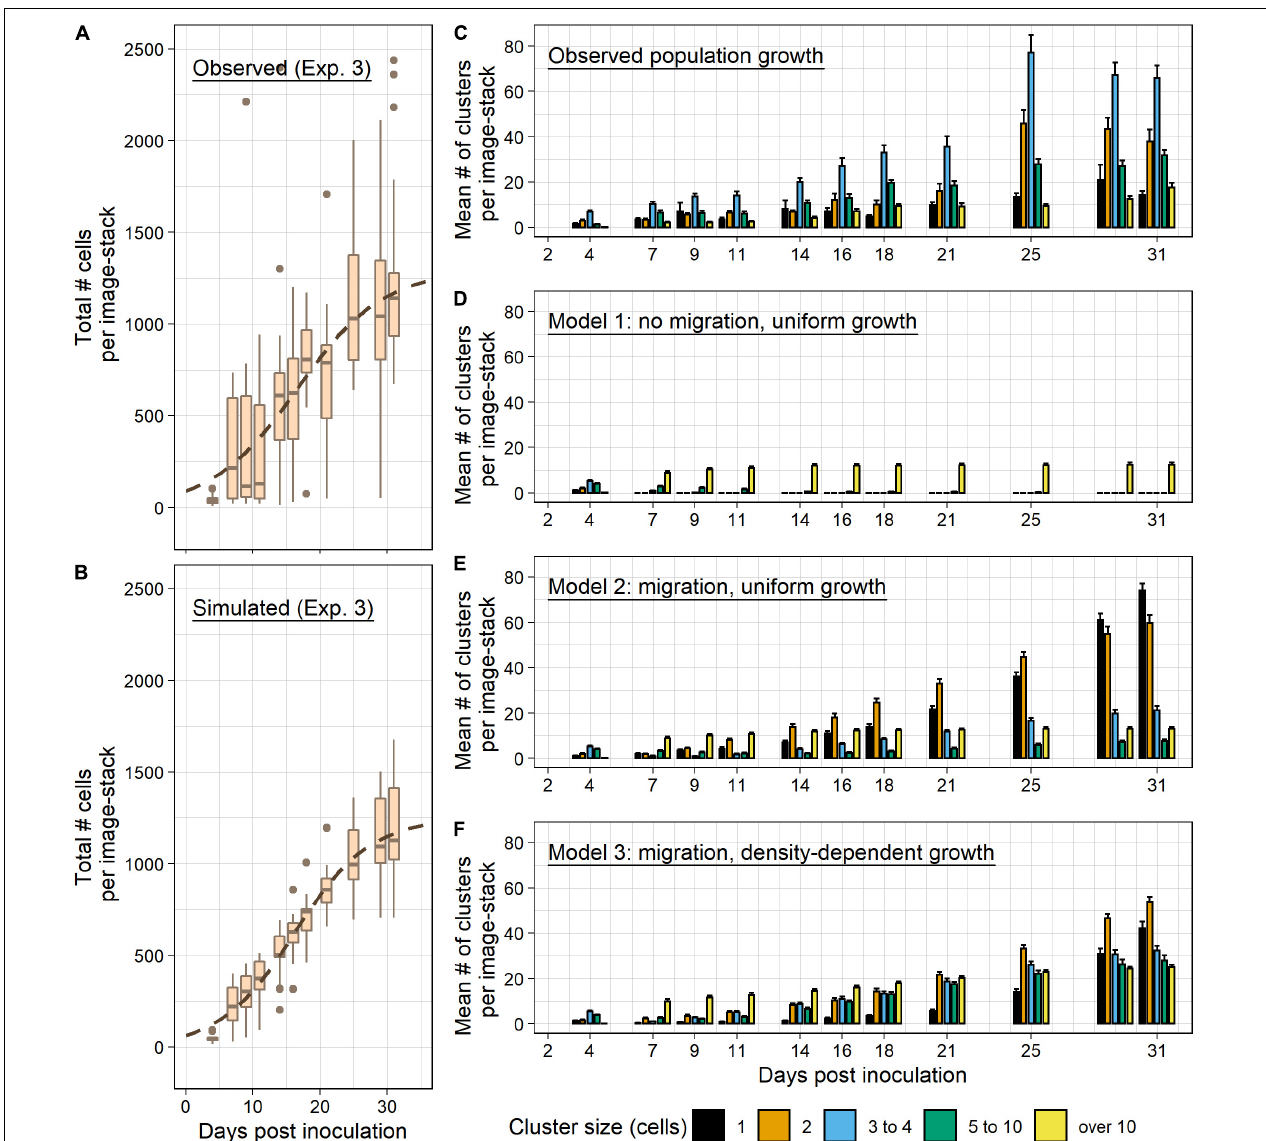
FIGURE 5 | Population growth and migration models. (A) Data from Experiment 3 ( B. minutum populations at 26 ◦ C) were used to create simulated population growth models. Total symbiont populations for each sample over time are represented by boxplots, with points showing outliers at each timepoint. The dashed line depicts a representative summary logistic model for all samples [ y = 1249.146/(1 + e (( 15 . 916 − x )/ 5 . 815 ) ]. (B) Simulated data was created using logistic model parameters generated from observed populations for each biological replicate. Boxplots indicate total symbiont populations for each simulated sample over time. The same representative summary logistic model as above is indicated by the dashed line. The modeled data shown was generated using a 1% migration rate and a cluster density-dependent growth rate. (C–F) The mean number of clusters per sample image for each cluster size are displayed for observed and simulated data. (C) Observed data replicated from Figure 4B for comparison. (D) Simulated data with no migration allowed and a logistic growth rate unique to each host anemone applied uniformly applied across sample populations. (E) Simulated data with cells allowed to egress from clusters to create new singlet clusters. Each cell was given a daily 1% probability of migration and had a uniformly applied growth rate. (F) Simulated data with a 1% probability of migration and a cell density-dependent transformation, in which daily population growth is allotted to cells using a square-root transformation to slow the growth of large clusters and instead apply population growth to smaller sized clusters. Error bars signify standard